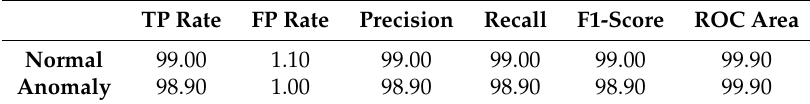
Table 38. Classification report for Bagging